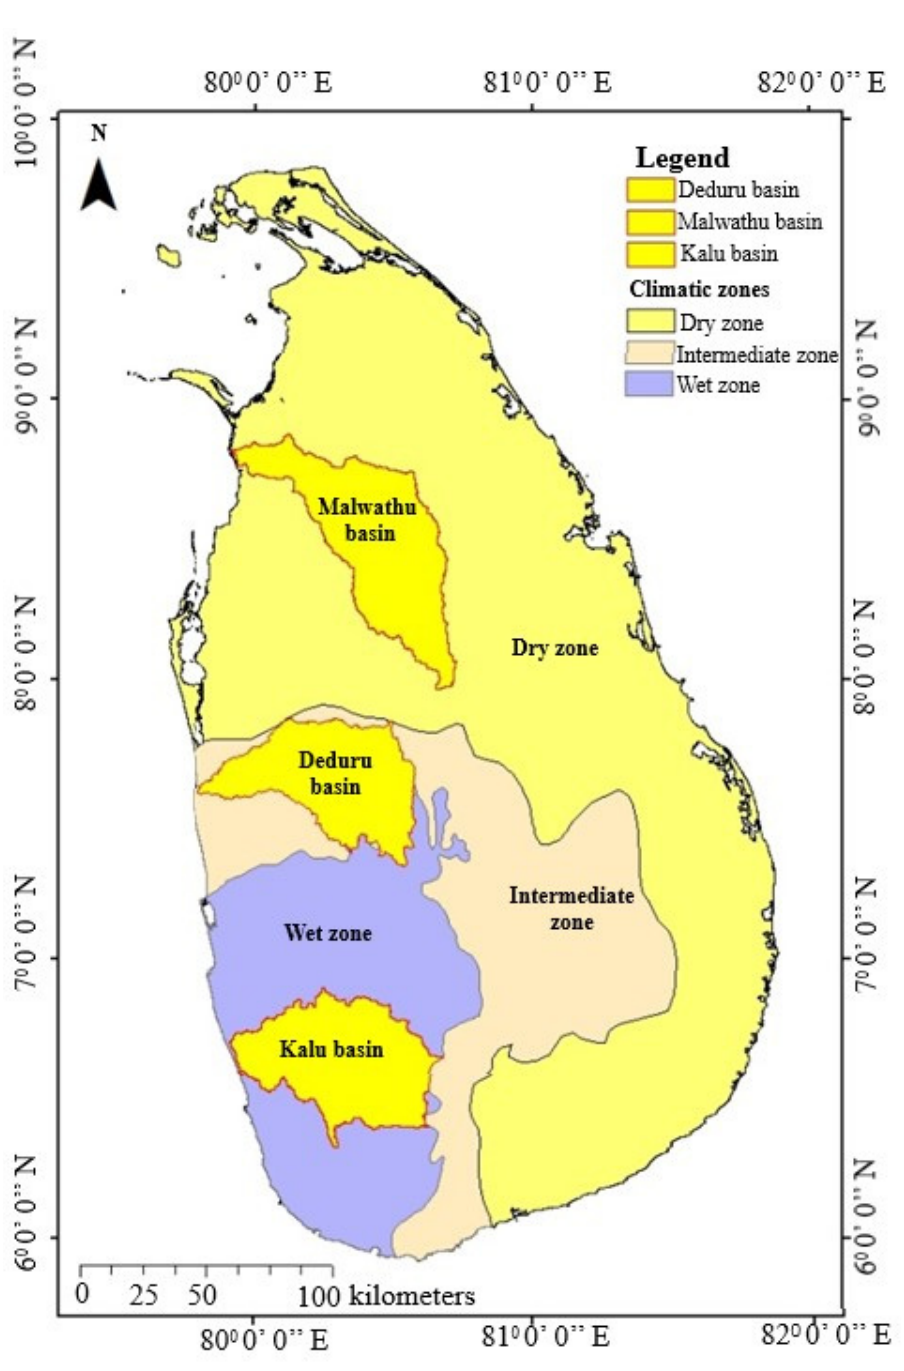
Figure 1. Climate zone of Sri Lanka.